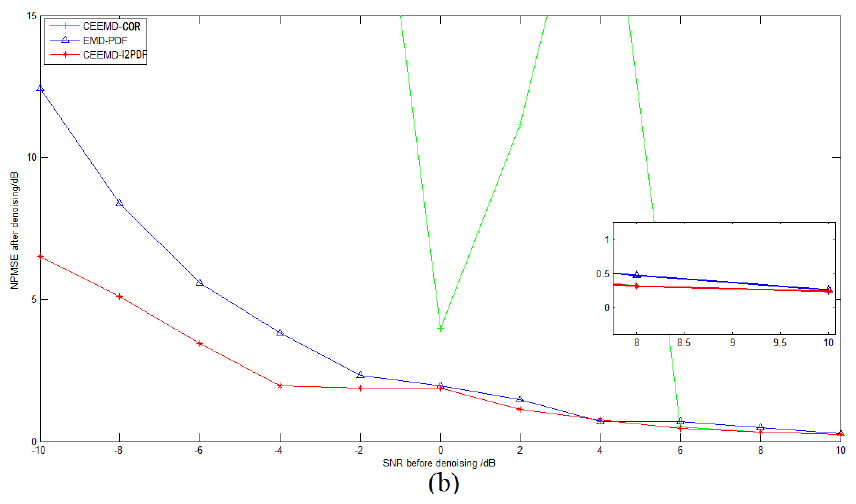
Figure 4. Results after denoising on the noisy signals. ( a ) Mean of SNR after denoising; ( b ) mean of Normalized Percent Mean Square Error (NPMSE) after denoising. CEEMD, Complementary Ensemble Empirical Mode Decomposition (CEEMD); COR, Correlation.